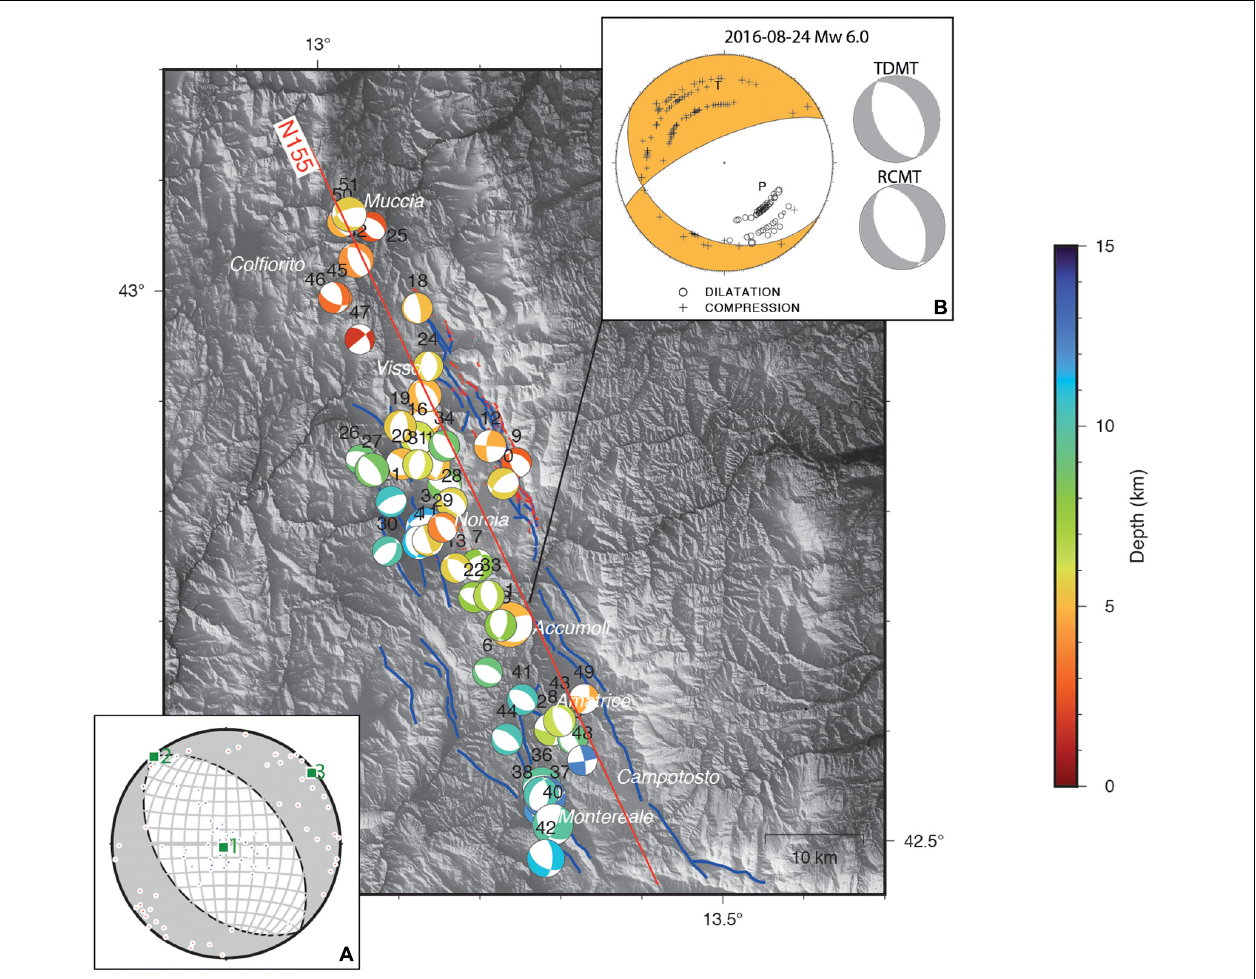
FIGURE 10 | FPFIT focal solutions for the earthquakes reported in Supplementary Table 1 , for “AVN” area; the red line, oriented N155, is the trace of the vertical section in Figure 11 ; the color scale is related to the depth of the hypocenters; bottom left inset: the mean focal moment tensor solution calculated from all the nodal planes. (A) The average focal mechanism obtained by unweighted moment tensor (Kassaras and Kapetanidis, 2018) has been calculated considering all the 51 earthquakes ( Supplementary Table 1 ) with M ≥ 4.0 that occurred inside the region interested by the AVN sequence and plotted in this map. (B) Distribution of polarities of the Mw 6.0 August 24, 2016 earthquake over its focal solution and the TDMT and RCMT solution for the same